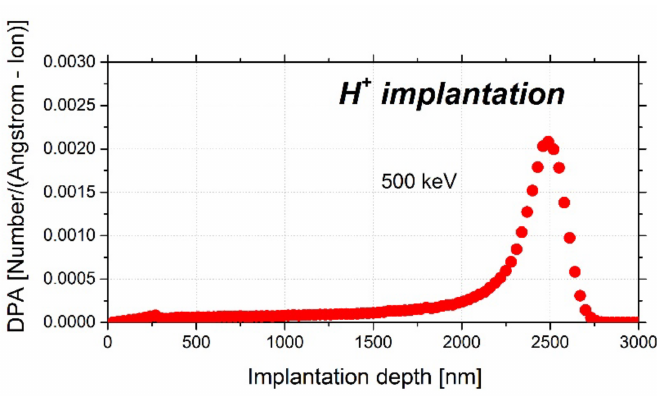
Figure 2. SRIM calculations of DPA for 500 keV H + ions incident on Fe-2.5Cr-0.6Mo. The detailed K-P calculation was used with a total number of ions in the calculation of 5 × 10 4